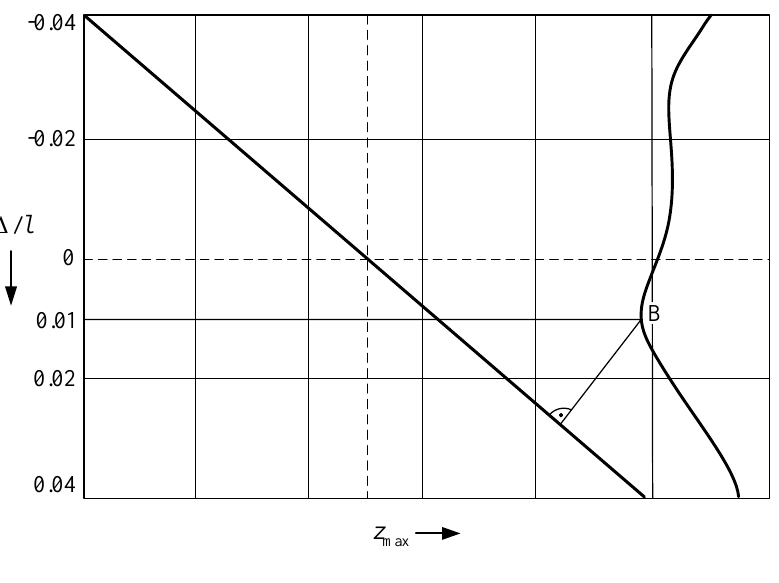
Figure 9. Dependence of maximum rebound amplitudes of the cantilever microstructure lyz / maxmax